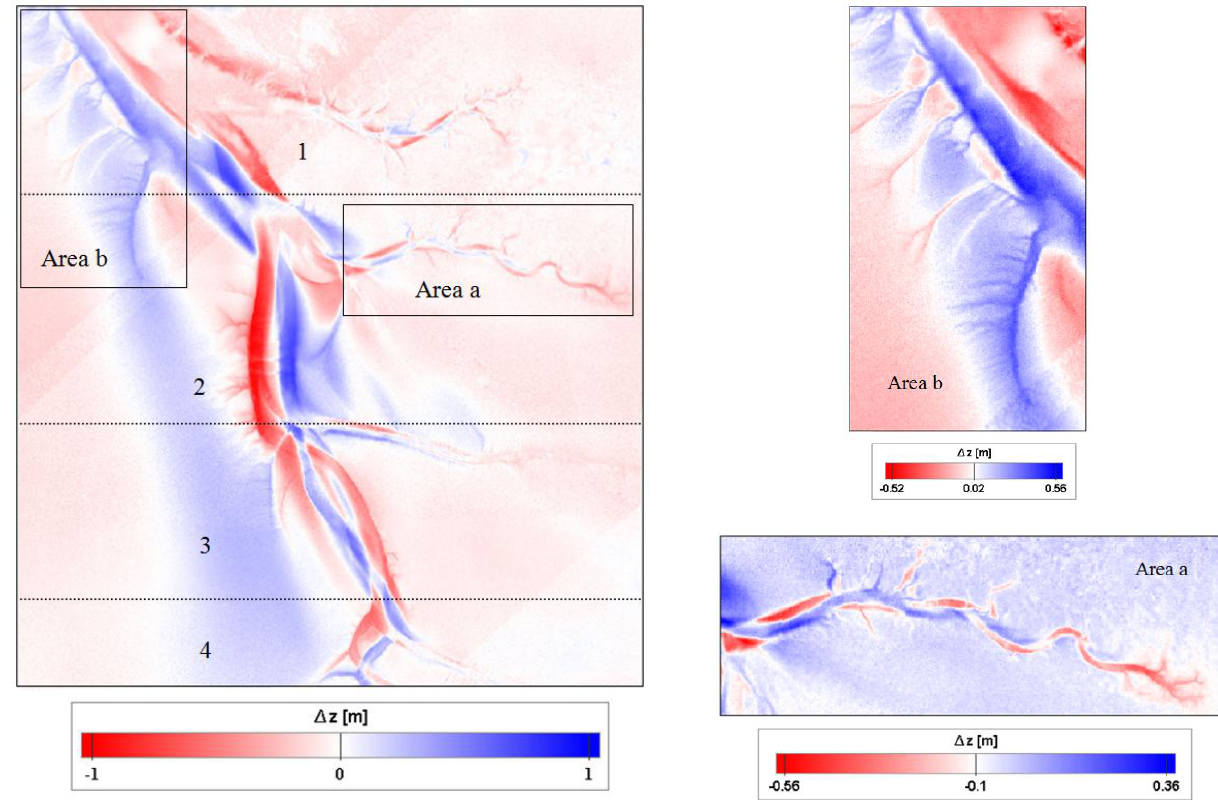
Figure 2. Height differences between the DTMs of 2012 and 2010 for the overall test site and two detailed views. Erosions refer to low values (red), depositions to high values